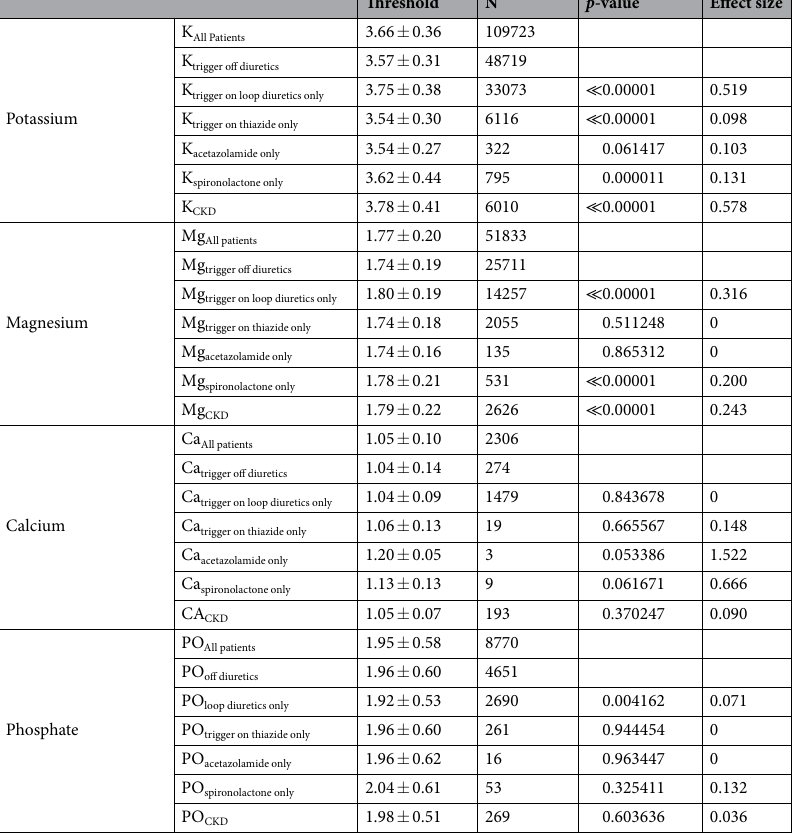
Table 1. Average electrolyte level before the replacement was ordered. The result of the two-tailed t test is added as well and effect size is Cohen’s d statistic (difference in means divided by pooled standard deviation). The p value is compared to all patients that are off diuretics and do not have